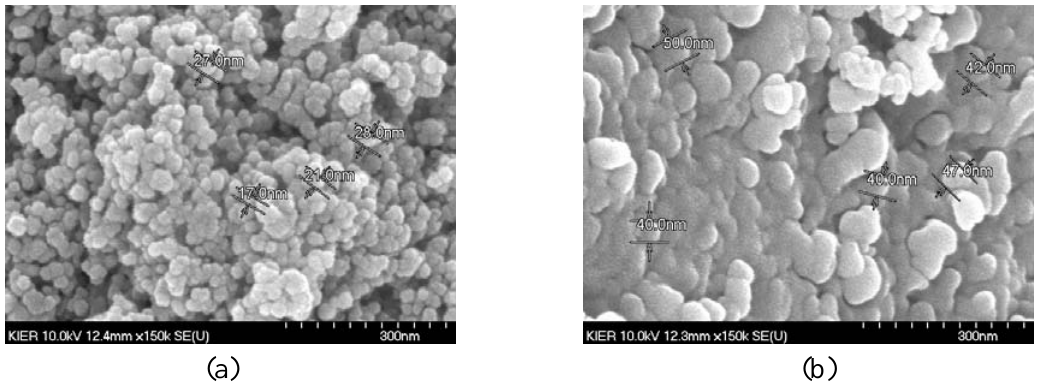
and (b) SiO coated F-doped SnO 2 2